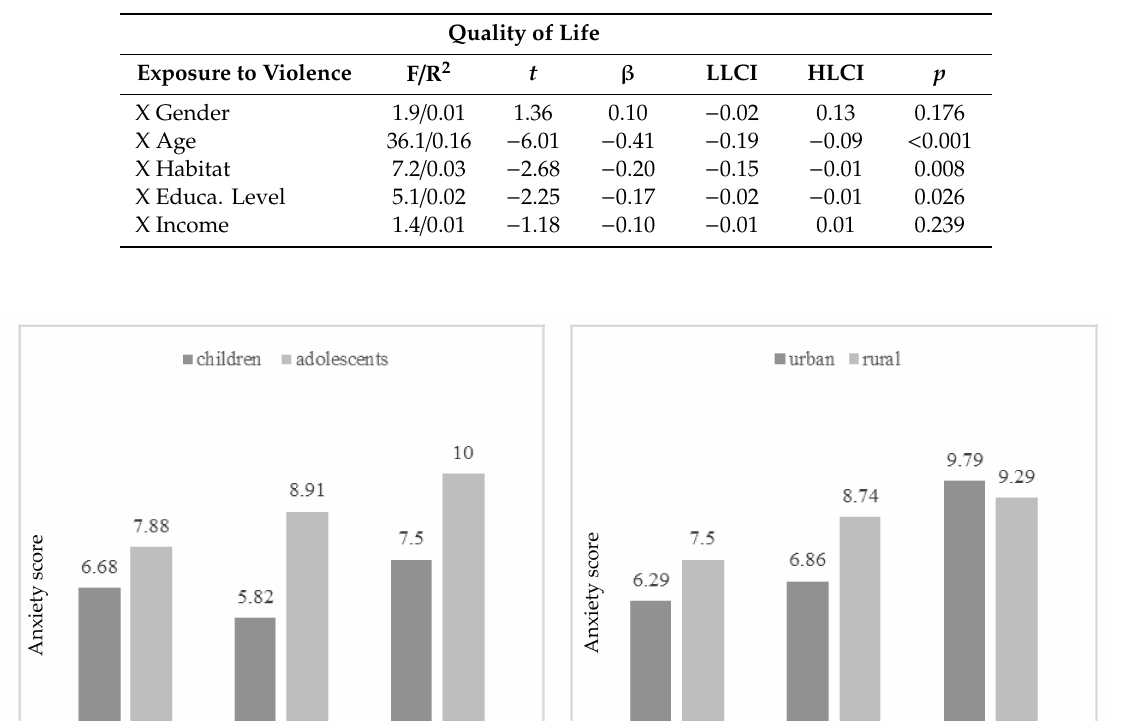
Table 9. Moderation analyses for quality of life.